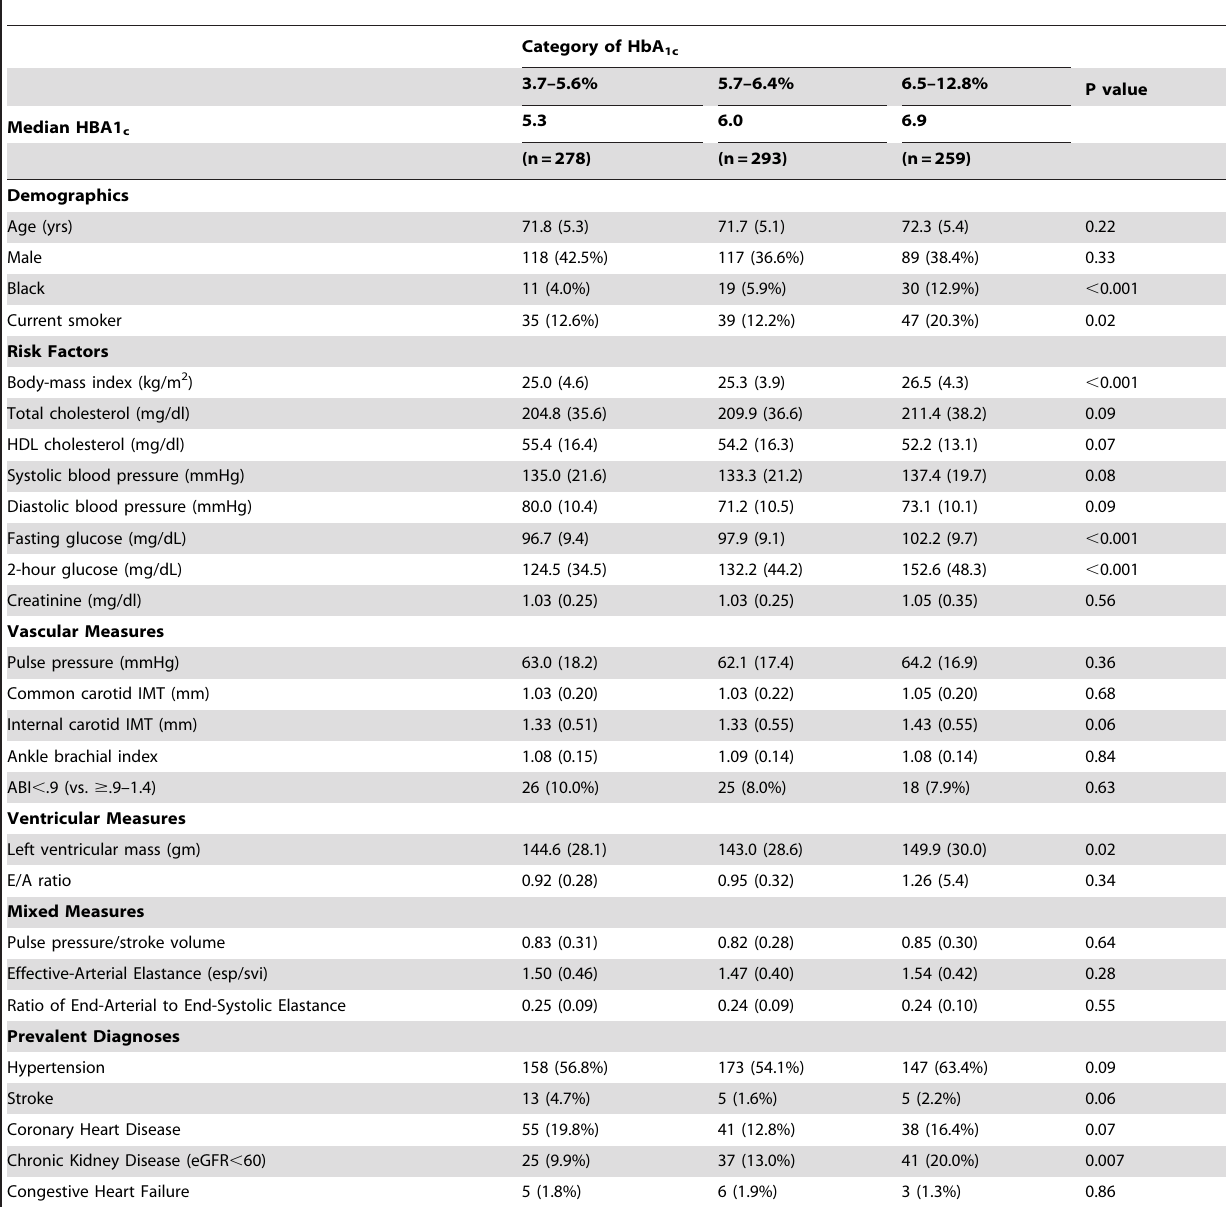
Table 1. Characteristics of Wake Forest CHS Participants without Diabetes Defined by Glucose or Medication, According to Categories of HbA 1c